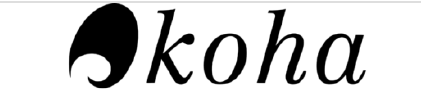
Librarians at Albright College chose the open source Koha ILS as the platform for the Bible in the Reel World